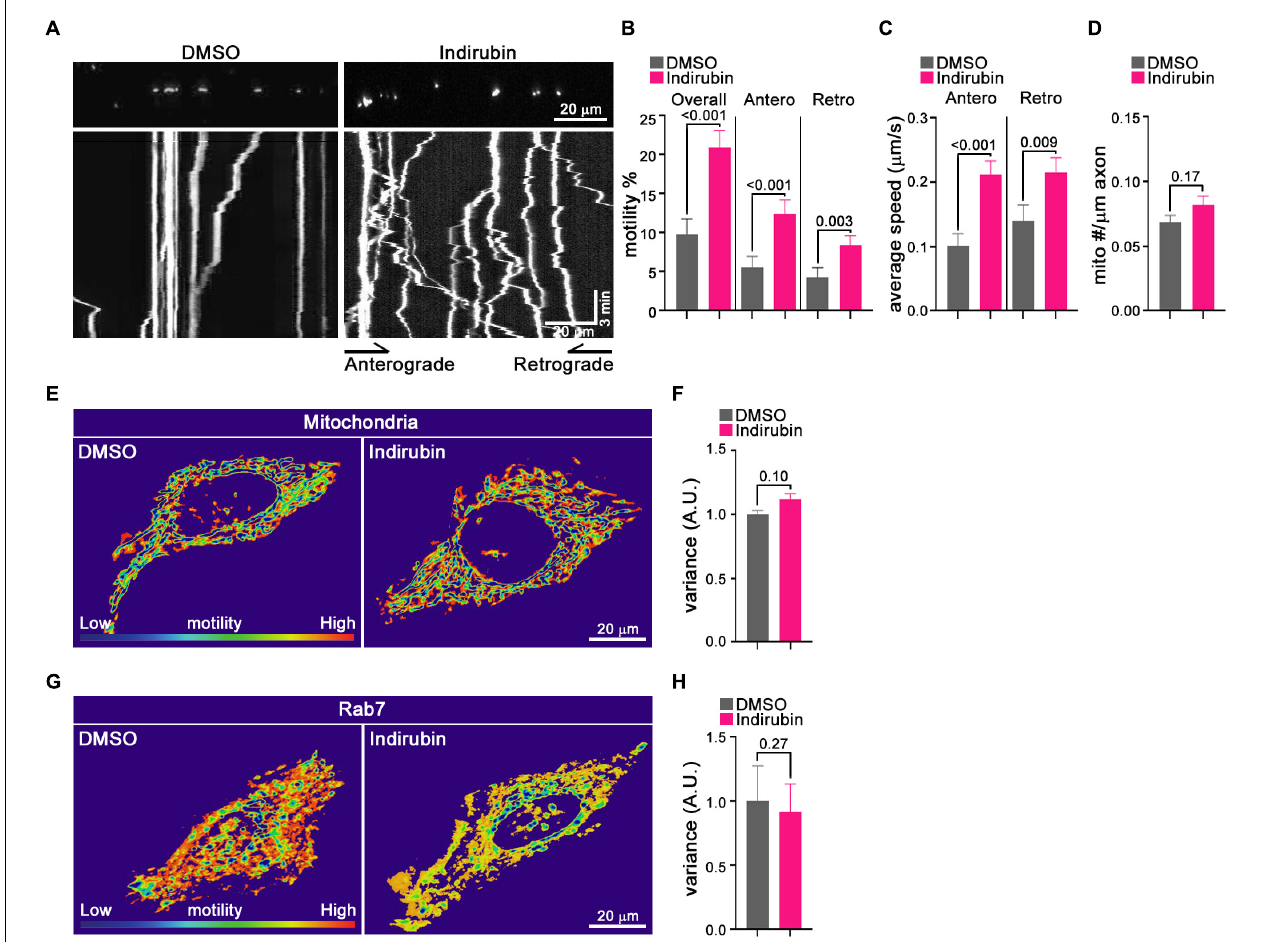
FIGURE 3 | Indirubin increases movement of axonal mitochondria. (A–D) Kymograph analysis of mitochondrial motility in rat cortical neurons treated with DMSO or indirubin. (A) Representative images of mitochondria in DMSO and indirubin treated axons. Top panels show images of multiple mitochondria in representative axon segments. Bottom panels show the corresponding kymographs generated from 3-min timelapse imaging of the axon segments. Below each image are kymographs built from 3 min time-lapse movies. The x -axis corresponds to the position of the mitochondrion in the axon shown above and on the y -axis is time proceeds downward. Anterograde movement is to the right. The percent of mitochondria that were motile (B) , their average velocity in either direction (C) , and mitochondrial density along the axon (D) were derived from kymographs as in (A) . Statistical comparisons to the DMSO-treated controls are from nonparametric Mann–Whitney tests. All experiments were done in three independent cultures. A total of 16 axon segments (109 mitochondria) for DMSO and 19 axon segments (156 mitochondria) for indirubin treated neurons were analyzed. Each axon segment was selected from a separate neuron. Bars represent the average motility of all mitochondria analyzed for each condition. Error bars represent SEM. (E–H) The movement of mitochondria and Rab7 in Hela cells treated with DMSO and indirubin. QuoVadoPro generates heatmaps based on the pixel variance of fluorescently labeled mitochondria (E) or Rab7 (G) . Scale bar, 20 µ m. The variance score was normalized to DMSO (F,H) . The statistical comparisons were by nonparametric Mann–Whitney test (F) and student t -test (H) . Each bar represents an average of 20–30 cells over three replicates, and error bars indicate